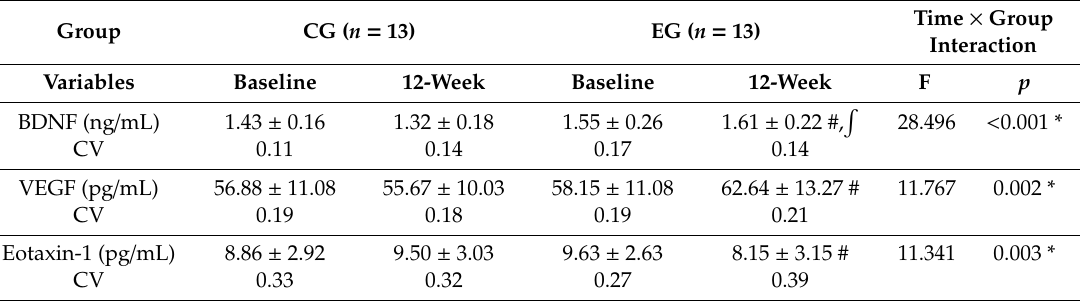
Table 5. The changes in the serum neurotrophic